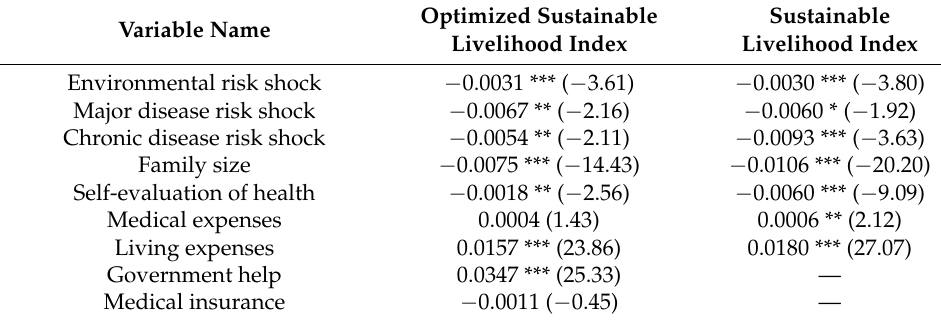
Table 6. Robustness test